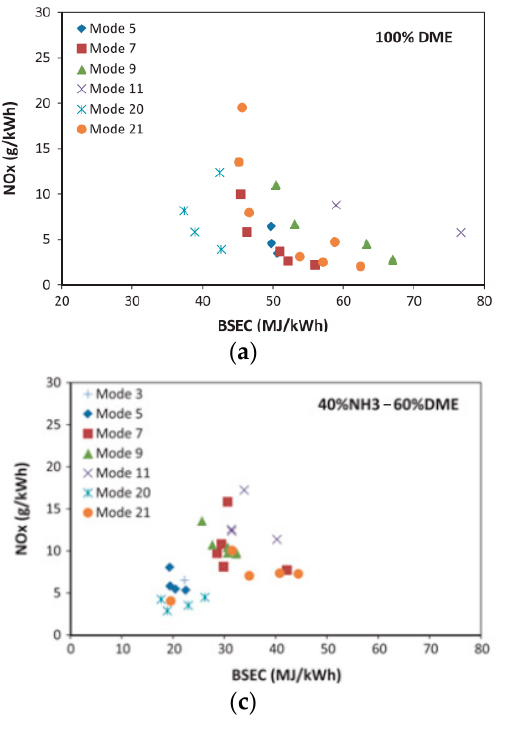
Figure 12. NOx emissions at different ammonia doping ratios; ( a ) 100% DME; ( b ) 20% NH 3 –80% DME; ( c ) 40% NH 3 –60% DME.